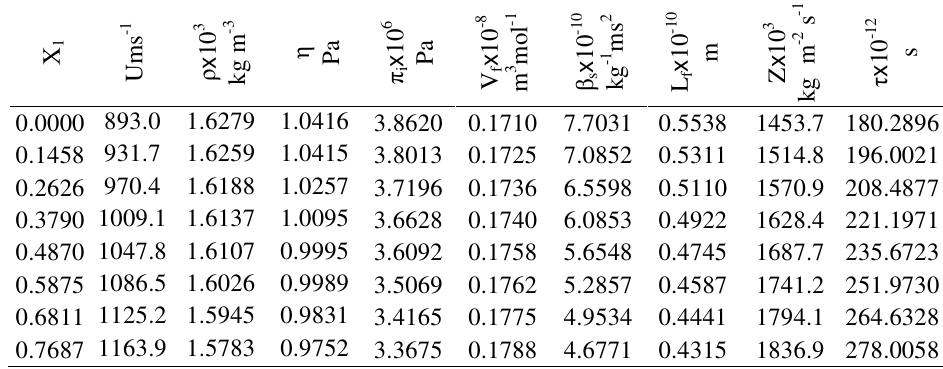
), free volume ( V ), f i